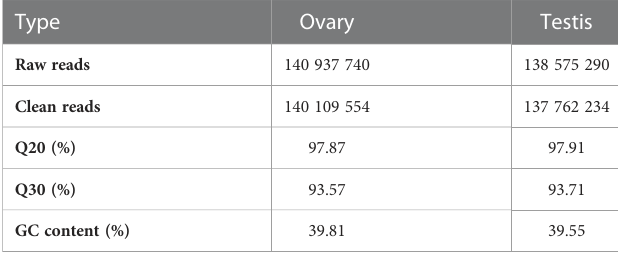
TABLE 2 Raw reads and quality control of reads for cDNA libraries of C. sinensis transcriptome. Type